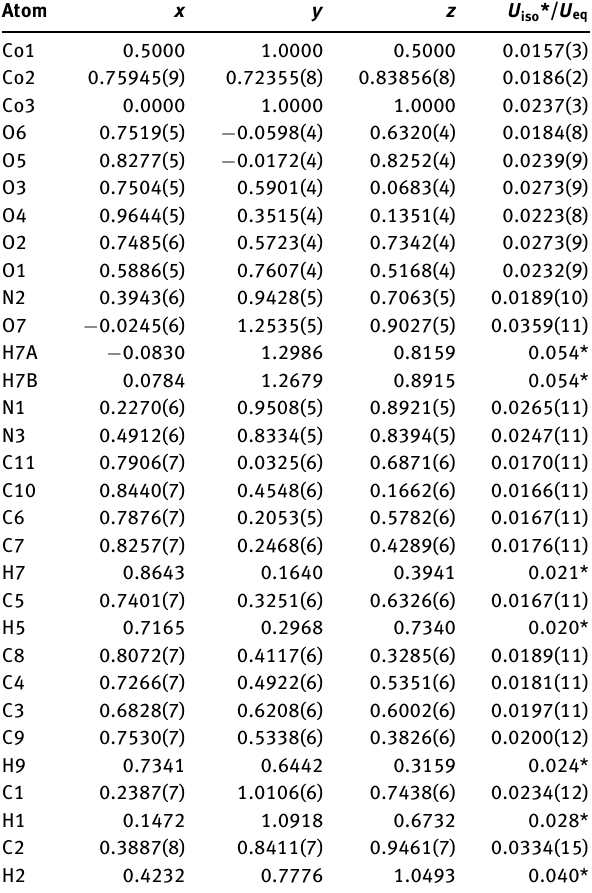
Table 2: Fractional atomic coordinates and isotropic or equivalent isotropic displacement parameters (Å 2